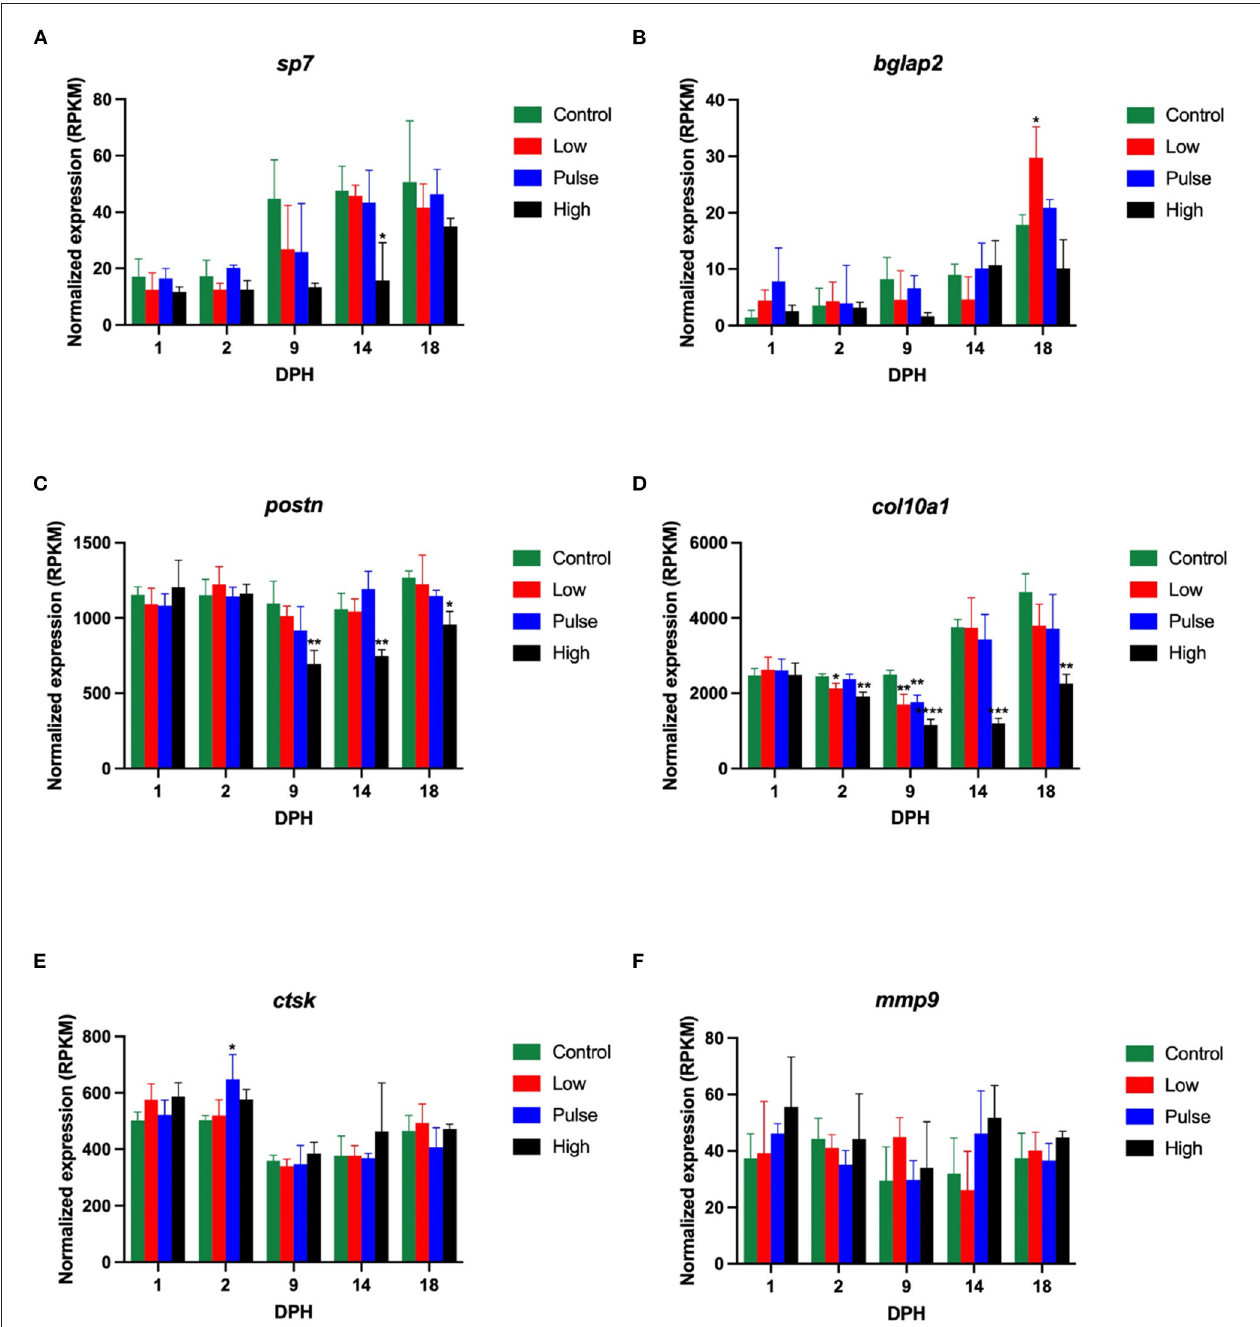
FIGURE 8 | Transcriptional levels of six genes involved in (A–D) bone formation and (E,F) bone resorption in Atlantic haddock larvae at 1, 2, 7, 9, 14, 18 dph. Data are presented as mean ± SD. RPKM, reads per kilobase million. Asterisks indicate statistical difference from the control fish: p < 0.05 = *, p < 0.01 = **, p < 0.001 = ***, p < 0.0001 =